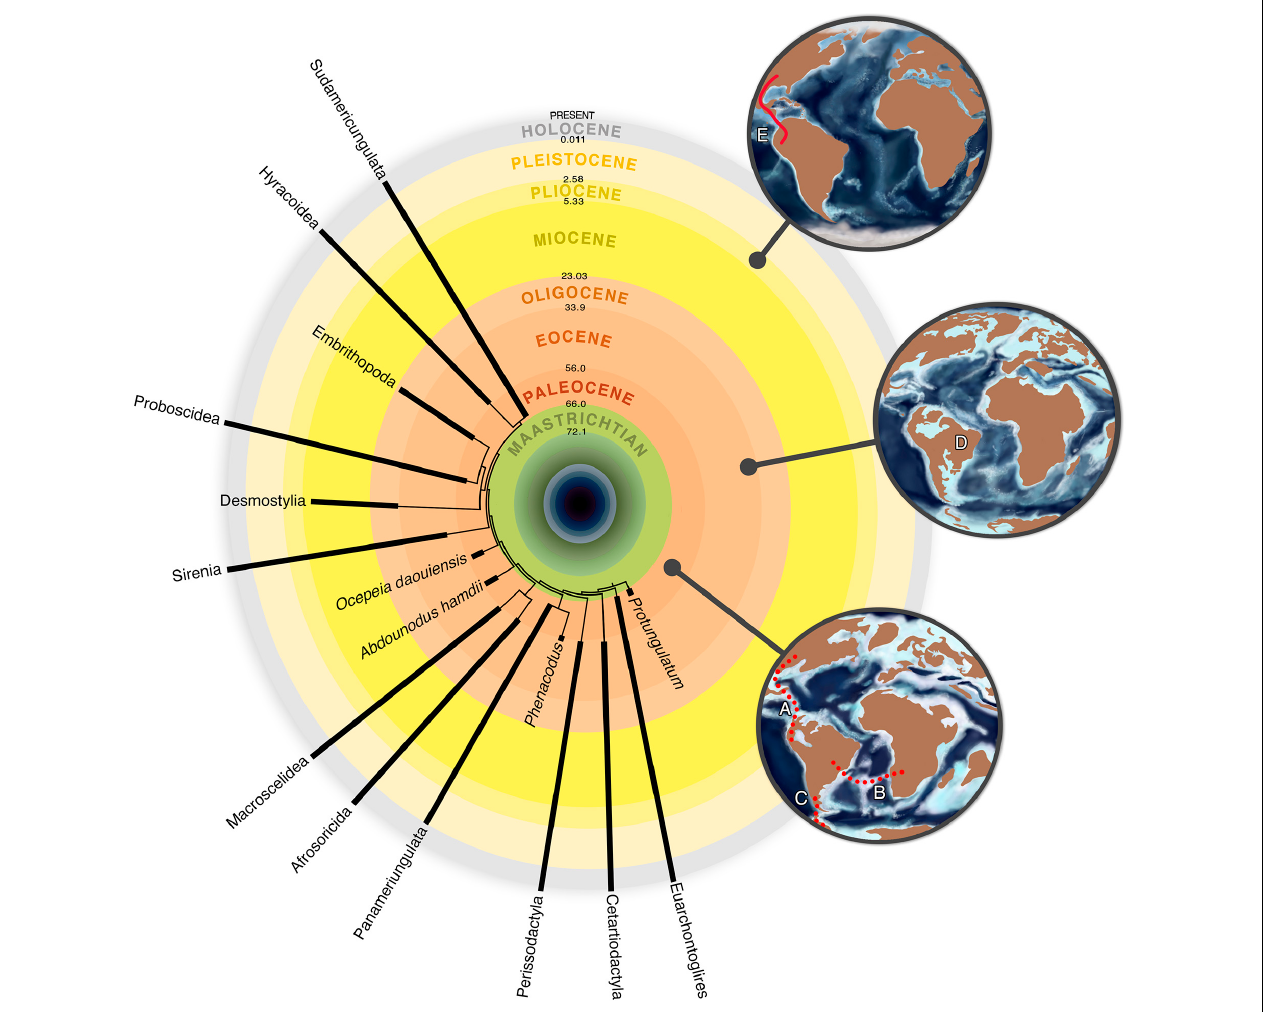
FIGURE 2 | Timescale-calibrated Sudamericungulata relationships within Eutheria, showing the configuration of the continents in three Cenozoic moments. (A) Panamerican route, connecting South America to Central and North America. (B) Atlantogea route, an island chain connecting South America and Africa. (C) “Weddelian Isthmus” route, connecting South America and Antarctica. All routes were intermittent connections. (D) Isolated South America continent. (E) Panamanian Isthmus connecting South America with Central and North America, interrupting the South America geographical isolation.